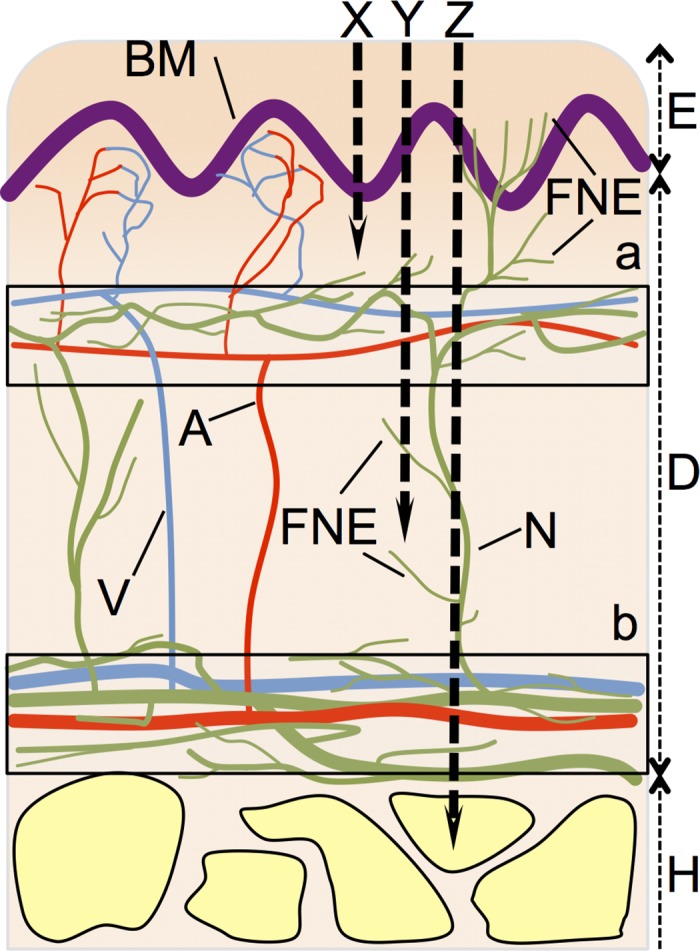
Simplified schematic of the relationship between human skin and nematocyst tubules.Simplified epidermis, dermis, and hypodermis are shown based on the reports of the biceps [20] and the lateral aspect of the upper arm [29] of human. E) epidermis, D) dermis, H) Hypodermis, A) artery, V) vein, N) nerve fiber, BM) basal membrane, FNE) free nerve ending from Aδ fiber, X) nematocyst of which tubule lengths ≤200 μm are corresponding to nematocysts of A. aurita and atrichous isorhiza of C. pacifica, Y) nematocyst of which tubule lengths from 200 μm to 600 μm are corresponding to microbasic mastigophore of C. yamaguchii and heterotrichous microbasic eurytele of C. pacifica (see Table 1), Z) nematocyst of which tubule lengths >600 μm are corresponding to heterotrichous microbasic eurytele of C. brevipedalia (see Table 1). Boxed a) Innervation range of the subepidermal nerve plexus and subpapillary plexus and boxed b) Innervation ranges of dermal nerve plexus and subcutaneous plexus.